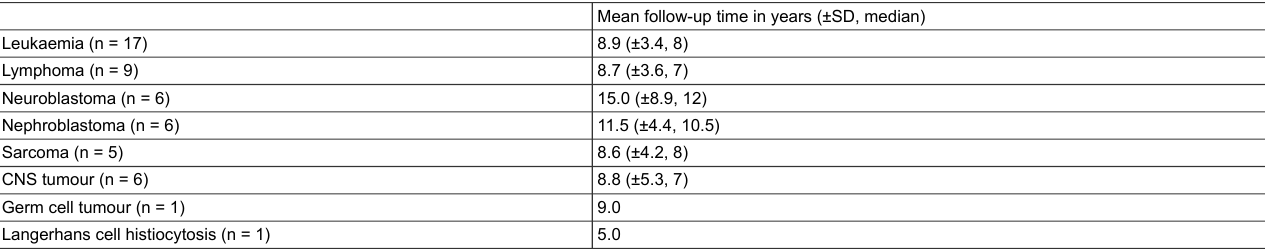
Table S1: Mean follow-up time since diagnosis for each disease